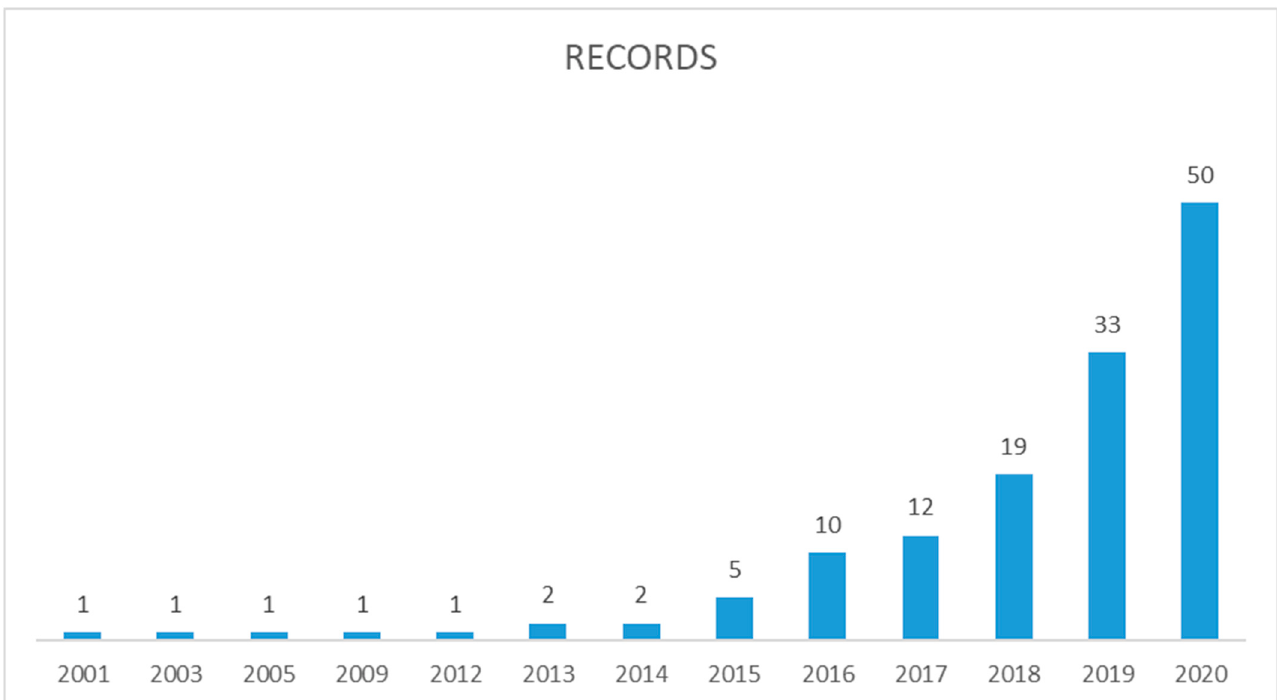
Figure 2. The numbers of publications per year. Obtained using VantagePoint.